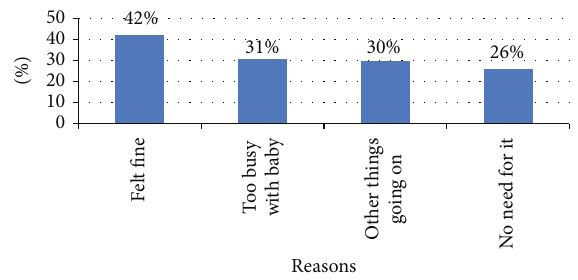
Figure 1: Top reasons reported for not receiving a postpartum checkup ( 𝑁 = 327